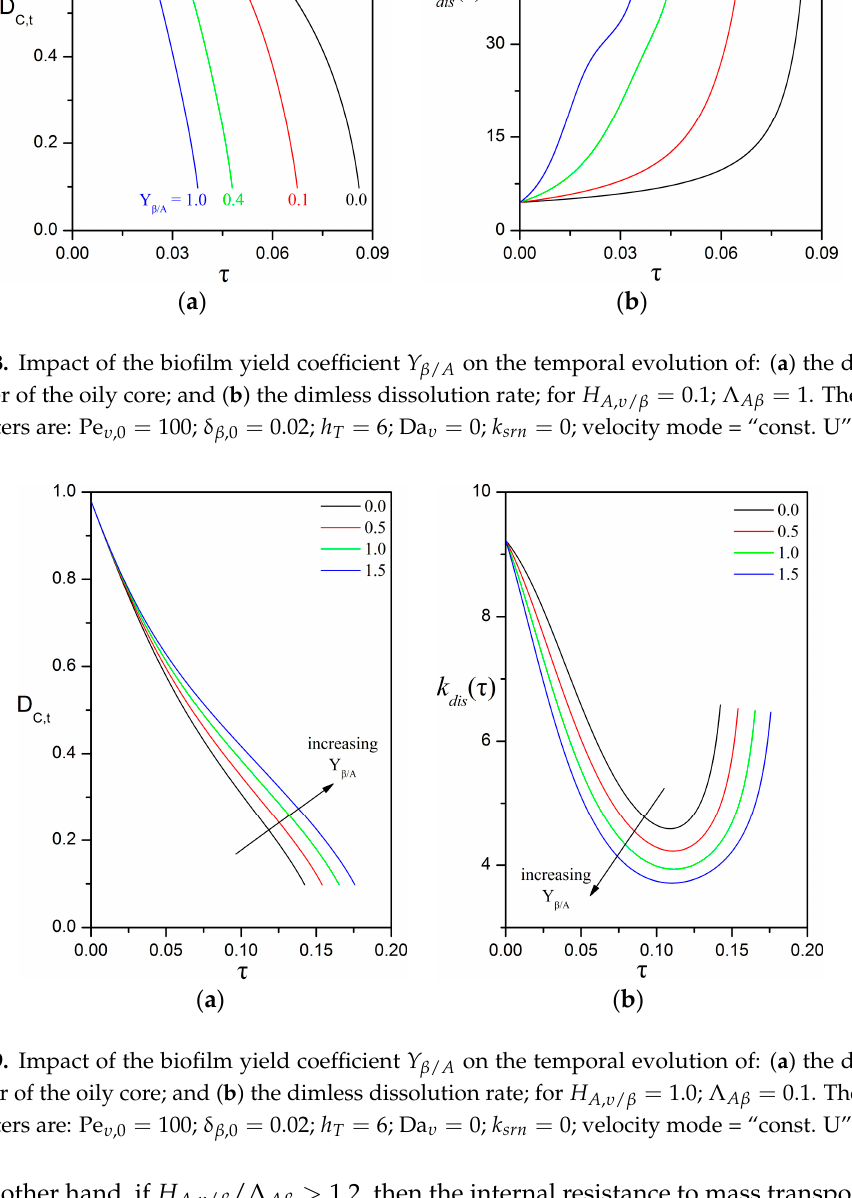
Figure 8. Impact of the biofilm yield coefficient (cid:1851) (cid:3081)/(cid:3002) on the temporal evolution of: ( a ) the dimless diameter of the oily core; and ( b ) the dimless dissolution rate; for (cid:1834) (cid:3002),(cid:3100)/(cid:3081) = 0.1 ; Λ (cid:3002)(cid:3081) = 1 . The other parameters are: Pe (cid:3100),(cid:2868) = 100 ; δ (cid:3081),(cid:2868) = 0.02 ; ℎ (cid:3021) = 6 ; Da (cid:3100) = 0 ; (cid:1863) (cid:3046)(cid:3045)(cid:3041) = 0 ; velocity mode = “const. U”. On the other hand, if (cid:1834) (cid:3002),(cid:3100)/(cid:3081) (cid:1993) (cid:3002)(cid:3081) ⁄